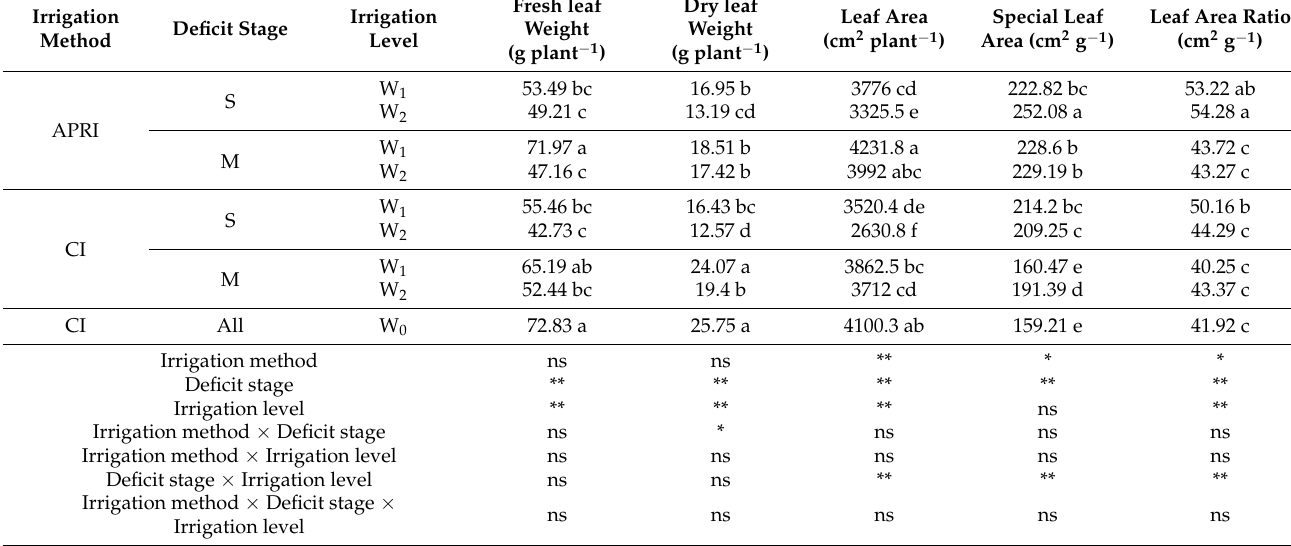
SLA and LAR at each deficit stage. Table 3. Effects of different irrigation levels and deficit stages on the leaf-related indexes of maize under alternate partial root-zone